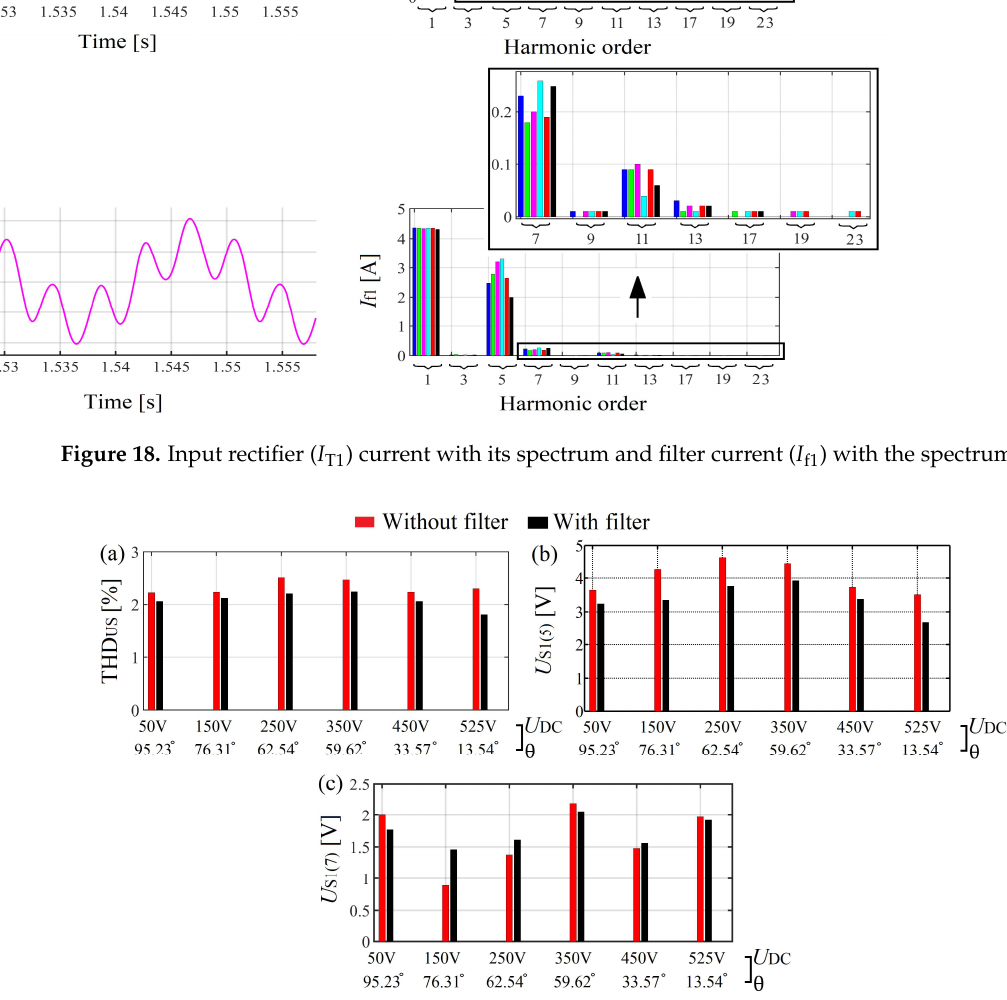
Figure 18. Input rectifier ( I T1 ) current with its spectrum and filter current ( I f1 ) with the spectrum.